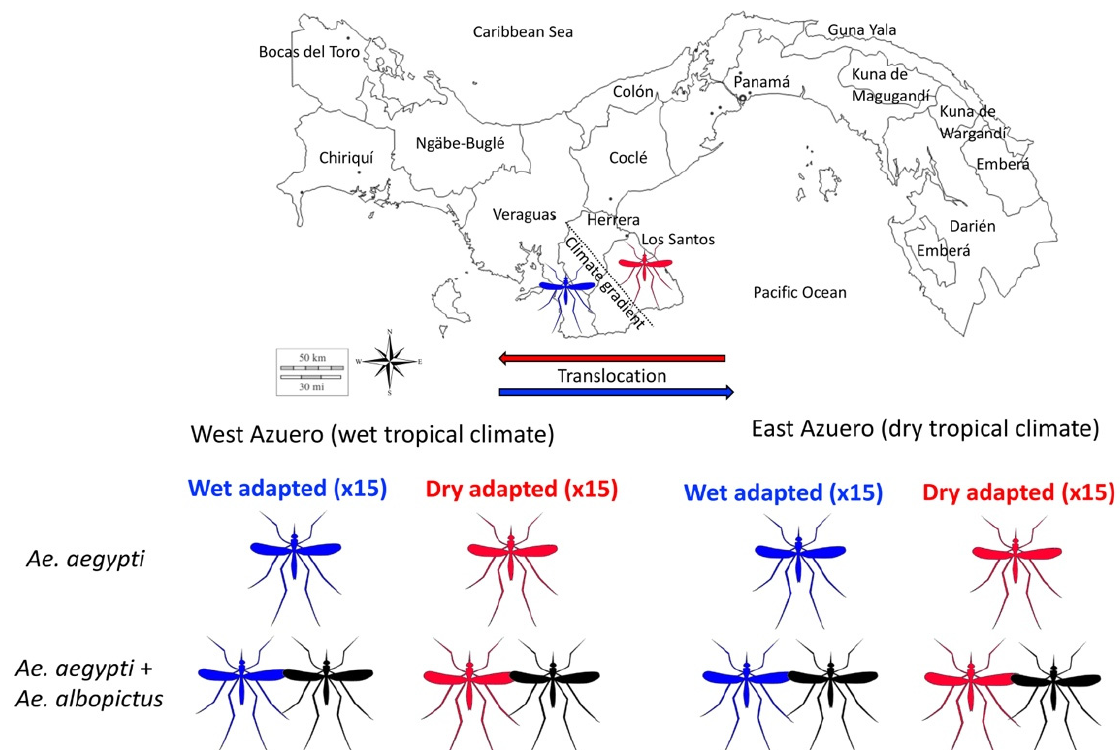
Figure 2. Reciprocal transplant experiment to test the hypothesis that local adaptation promotes the persistence of Ae. aegypti in the presence of a competitor. Laboratory generated populations of “dry adapted” Ae. aegypti sourced from the dry and hot East Azuero Peninsula (red mosquito) could be tested for fitness phenotype and genotypes as they develop both in their local environment and when transplanted across a climate gradient to the wetter region of the Southwest Azuero Peninsula. Similarly, “wet adapted” Ae. aegypti from the West Azuero Peninsula (blue mosquito) are transplanted to the dry East Azuero Peninsula as well as being tested under local conditions. In addition, the fitness phenotypes and genomic variation of both wet and dry adapted Ae. aegypti should be characterised with and without its competitor, Ae. albopictus (black mosquito), under both local and contrasting climate conditions.